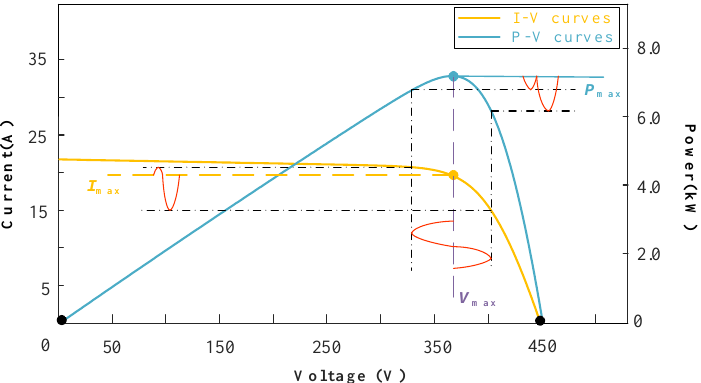
Figure 4. P-V and I-V curves of photovoltaic output under secondary ripple.